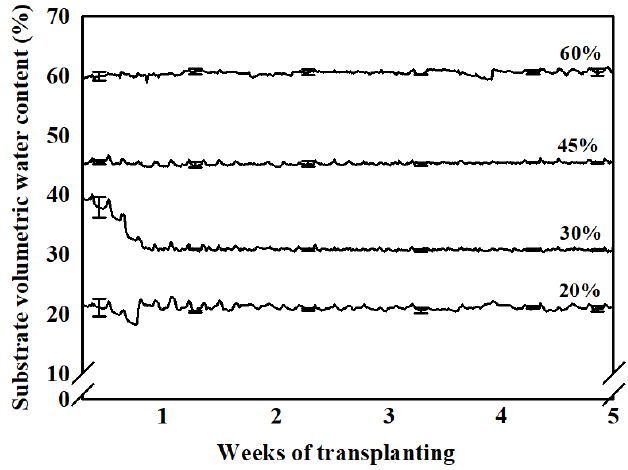
Figure 1. Average volumetric water content of the substrate at 20%, 30%, 45% and 60% water content treatments for 5 weeks. Lines and bars indicate the means and standard errors, respectively ( n =